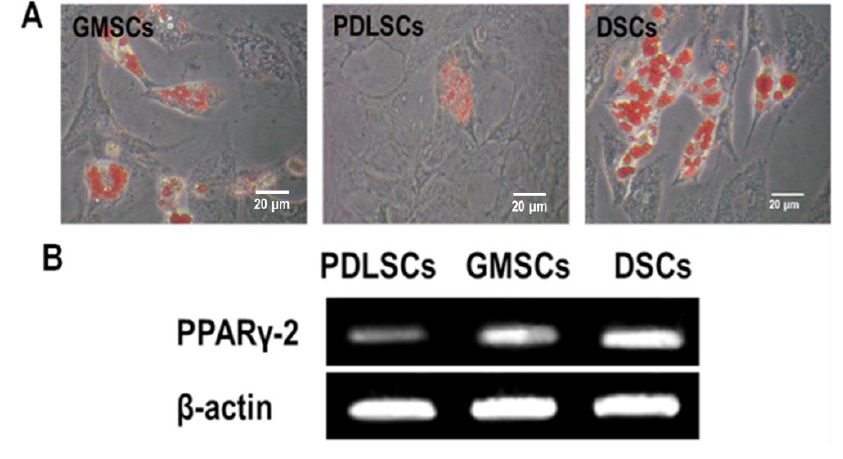
Figure 8. Adipogenic differentiation of GMSCs, PDLSCs and DSCs (P3) after four weeks of adipogenic induction. ( A ) Representative images of intracellular lipid vacuoles that appeared in all tested cells, as confirmed by Oil Red O staining; and ( B ) The expression of an adipogenic gene PPARγ detected by RT-PCR.